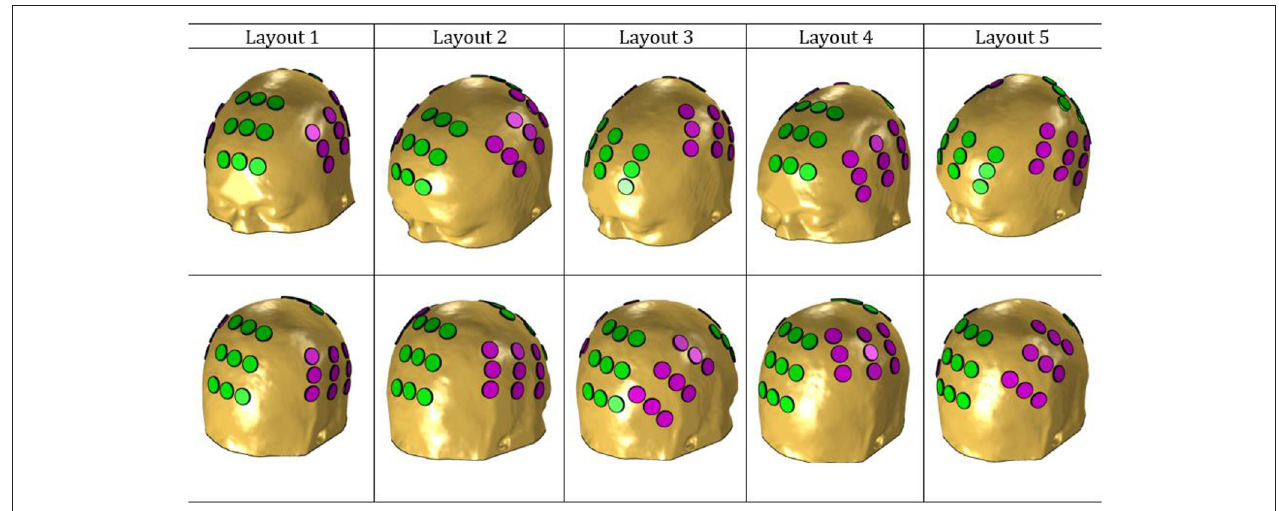
FIGURE 1 | NovoTAL layouts used in this work. The anterior-posterior pair is colored in green and the left-right in magenta.